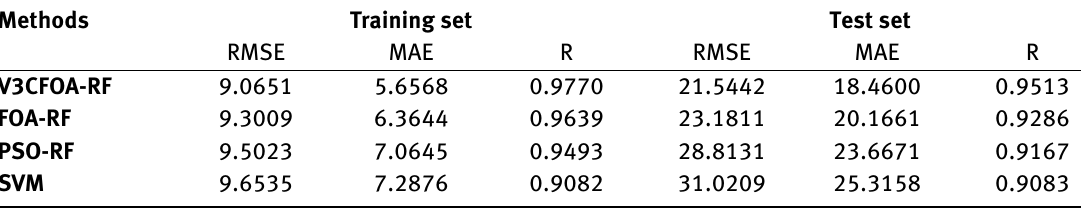
Table 2: Comparison results of the four methods